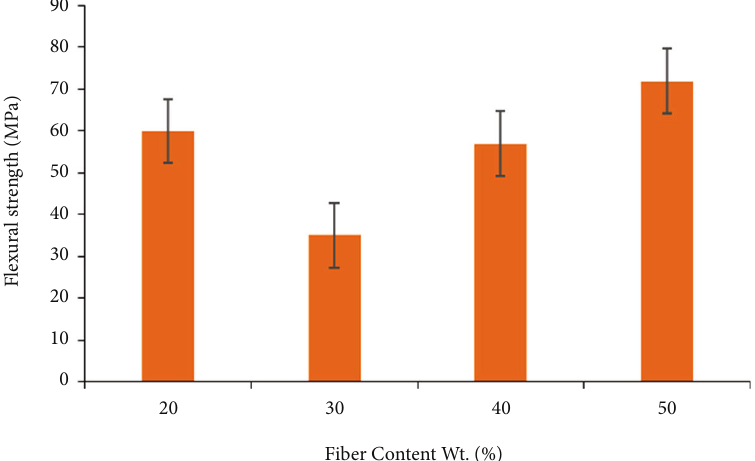
Figure 6: Flexural strength vs. fi ber content.